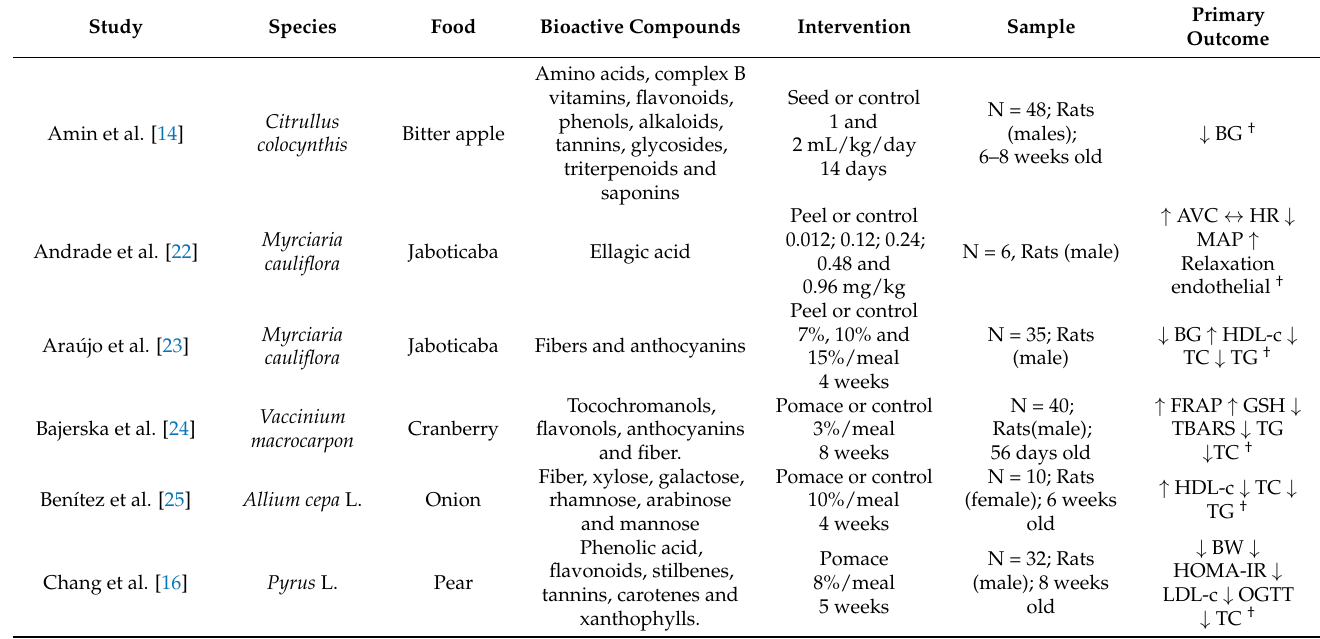
Table 1. Summary of the studies included in the review that investigated supplementation using fruit or vegetable-based by-products in animal